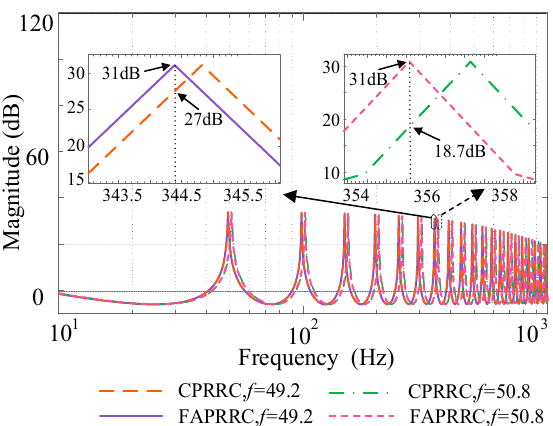
Figure 6. Amplitude frequency characteristics of CPRRC and Newton ‐ FAPRRC. In this paper, M = 4, so ˆ d = d + 1, N (cid:48) i = N − ˆ d = N i − 1 in Figure 4. Taking 7th harmonic as an example, if grid frequency is 49.2 Hz, N = f s / f = 203.25, z − N can be expressed as z − N = z − 202 z − 1.25 , ˆ d = 1.25, N (cid:48) i = 202. It can be seen that the amplitude